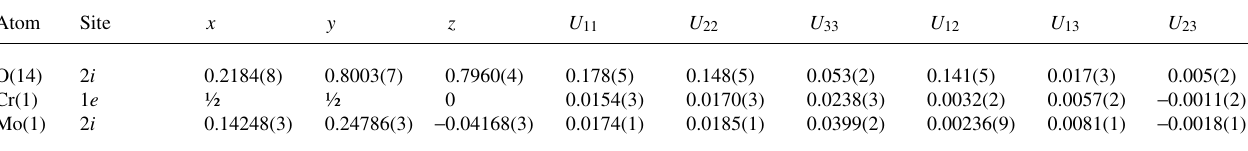
Table 3. Atomic coordinates and displacement parameters (in Å 2 )